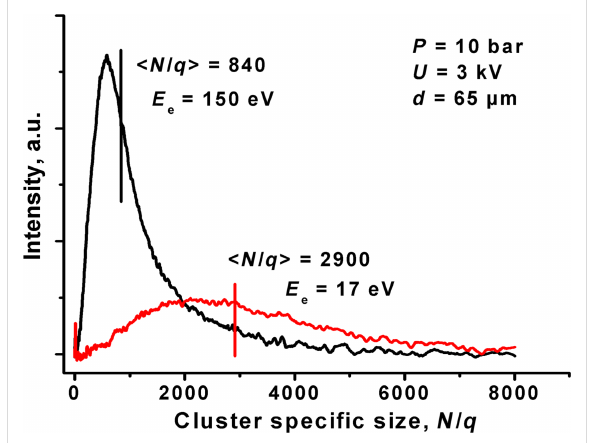
Figure 1: Mass spectra of the argon cluster beam ionized by elec- trons with the energies of 17 and 150 eV. The vertical lines represent the mean cluster specific sizes